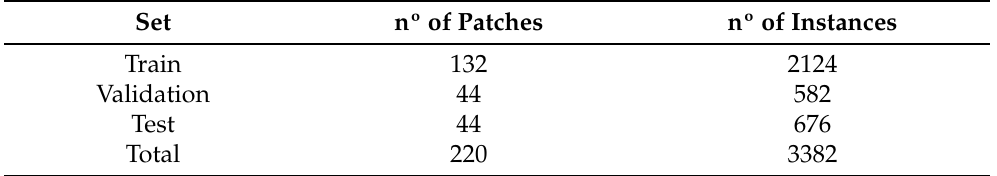
Figure 2. Example of an annotated patch. The bounding boxes for each tree considered as ground−truth are represented in white. Table 1. The number of image patches and trees annotated as ground-truth in each set. The training, validation, and test sets comprised 60%, 20%, and 20% of the image patches,